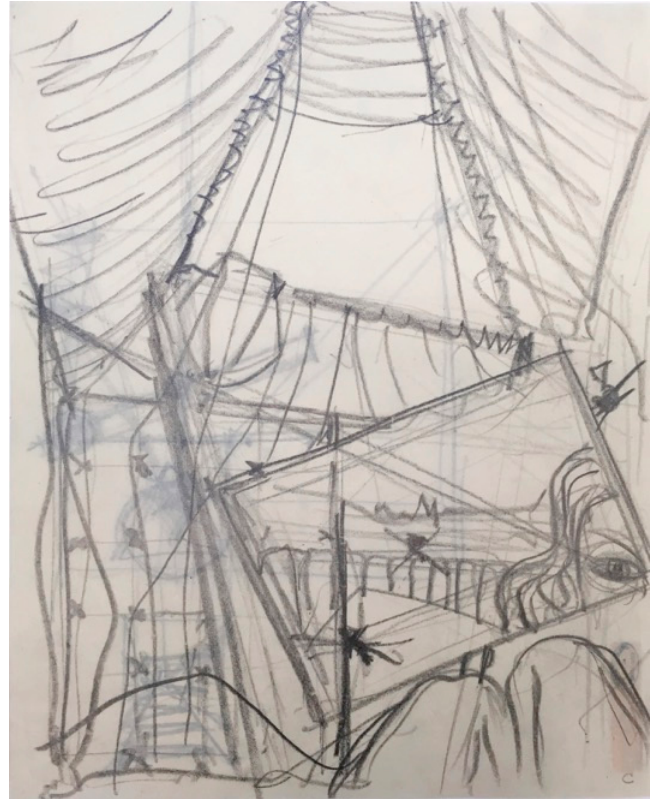
Figure 3. ACM P.9C.922.3: Preparatory sketch for the central perspective from the bed, with a feminine face reflected in the